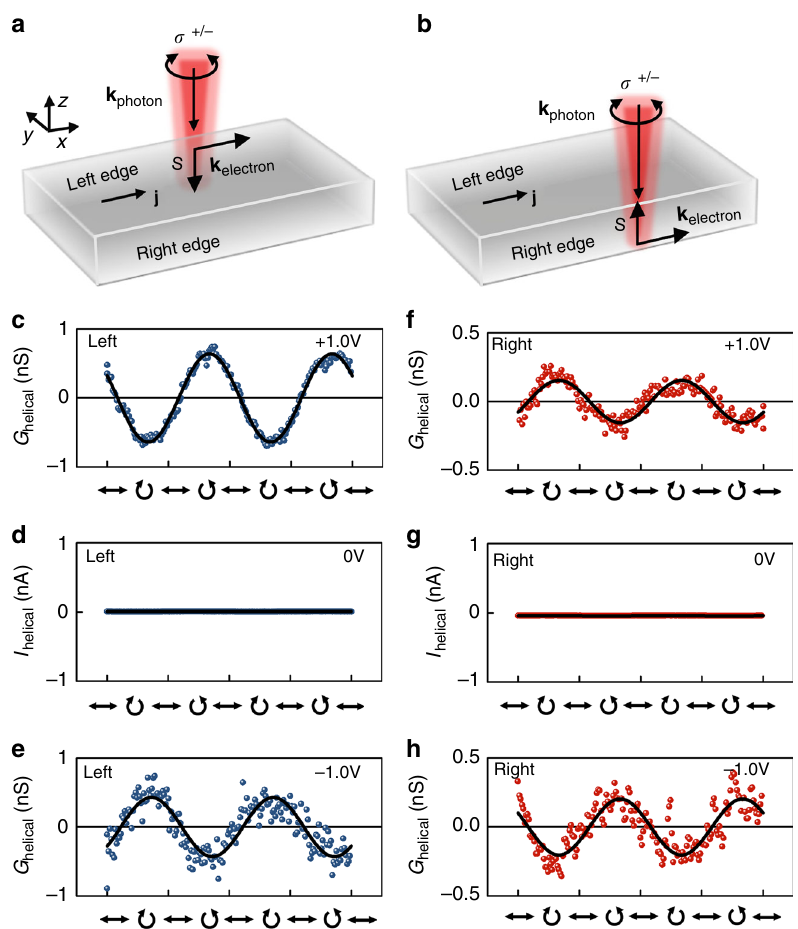
Fig. 3 Helicity vs. bias and facet dependence of helical photoconductance. a, b Sketch of a BTS platelet with dark current j along the x -direction, when a bias V fi nes the direction of the electron wave vector k sd is applied. The current de electron at the left and right edge. The electron spin-polarization S is perpendicular to k electron and points in opposite directions at the two edges. In a [ b ], the left [right] edge is excited with a circularly polarized light with the photon wave vector k photon pointing downwards. c – e Δ G helical vs. the laser helicity at the left edge for V sd = + 1 V ( c ), 0 V ( d ), and – 1 V ( e ). The polarization is tuned with a quarter waveplate for an excitation scheme as sketched in a ). f-h Similar data for the right edge for an excitation scheme as sketched in b . All measurements are performed at P laser = 230 µ W and room temperature